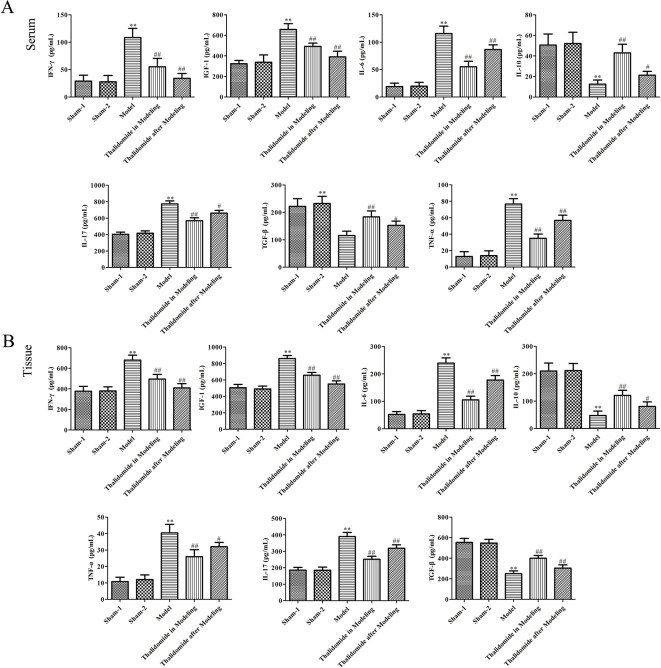
Effects of thalidomide on the production of inflammatory cytokines in mice induced with TNBS. Thalidomide treatment could obviously inhibit production of IFN-γ, IGF-1, IL-6, IL-17 and TNF-α, and promote the production of IL-10 and TGF-β in serum (A) and colonic tissues of mice from different groups (B). The results were expressed as the mean ± SD. **P < 0.01 compared with sham-1 and sham-2 groups, #
P < 0.05, ##
P < 0.01 compared with the model group.